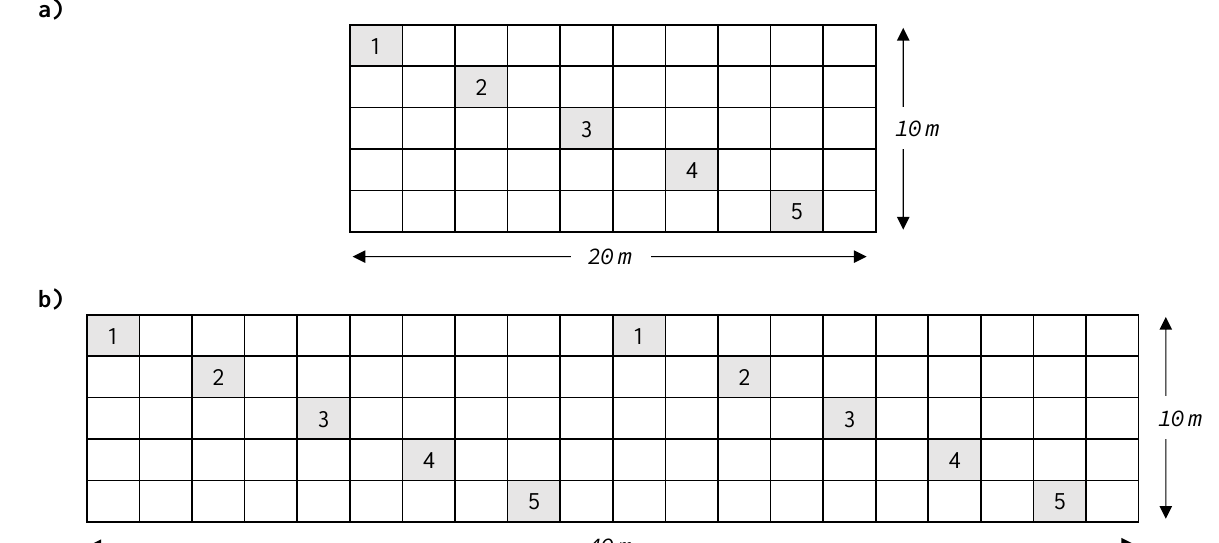
Figure 2. Stream sampling design, depicting 10 m by 20 m quadrats subdivided into 50 2 m by 2 m sub-quadrats. The sections sampled are highlighted in gray, for stream cross-sections that are ( a ) 20 m to 39 m wide and ( b ) 40 m to 79 m wide.